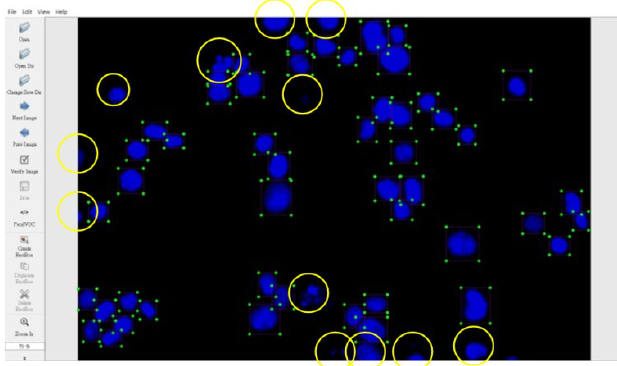
Figure 10. Region selection of the normal cell nuclei for rectangular box annotation using LabelImg (the yellow circles represent abnormal cell nuclei that were not annotated). Sensors 2020 , 20 , x; doi: FOR PEER REVIEW 12 of 22